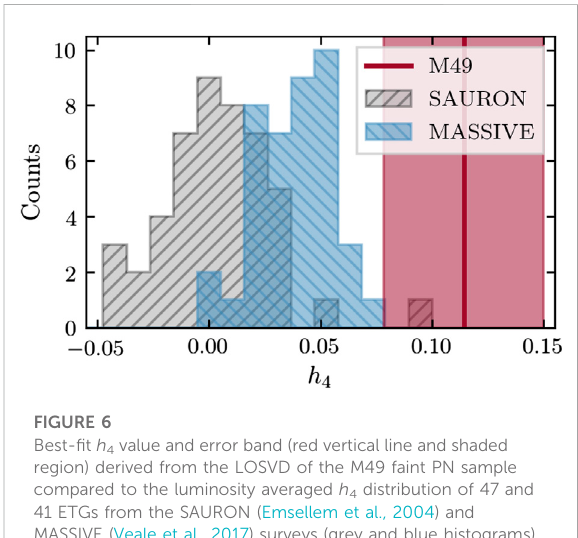
FIGURE 6 Best- fi t h 4 value and error band (red vertical line and shaded region) derived from the LOSVD of the M49 faint PN sample compared to the luminosity averaged h 4 distribution of 47 and 41 ETGs from the SAURON (Emsellem et al., 2004) and MASSIVE (Veale et al., 2017) surveys (grey and blue histograms). Image reproduced from Hartke et al. (2018) with